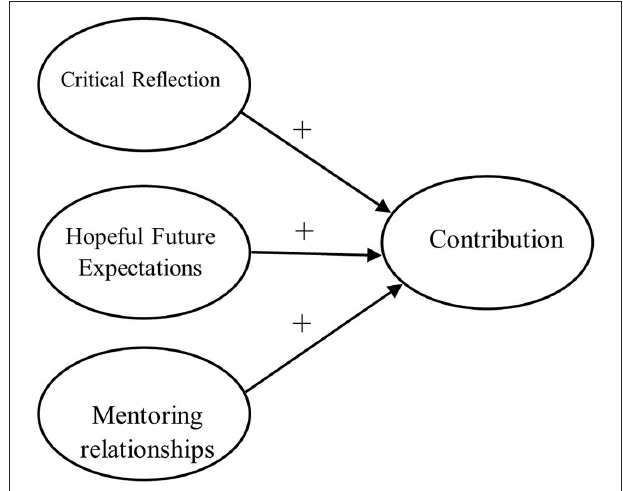
FIGURE 1 | Conceptual model. Positive hypothesized relations are depicted ( + ) between youth’s critical reflection, hopeful future expectations, and mentoring relationships and their